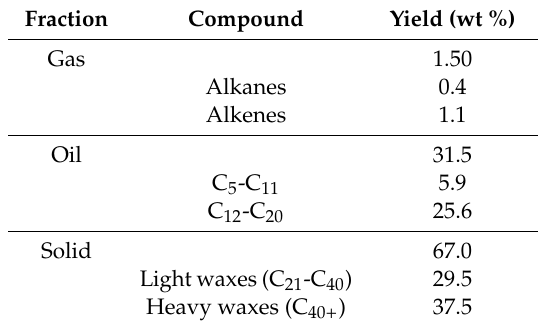
Table 3. Mass composition (wt %) of volatiles from HDPE